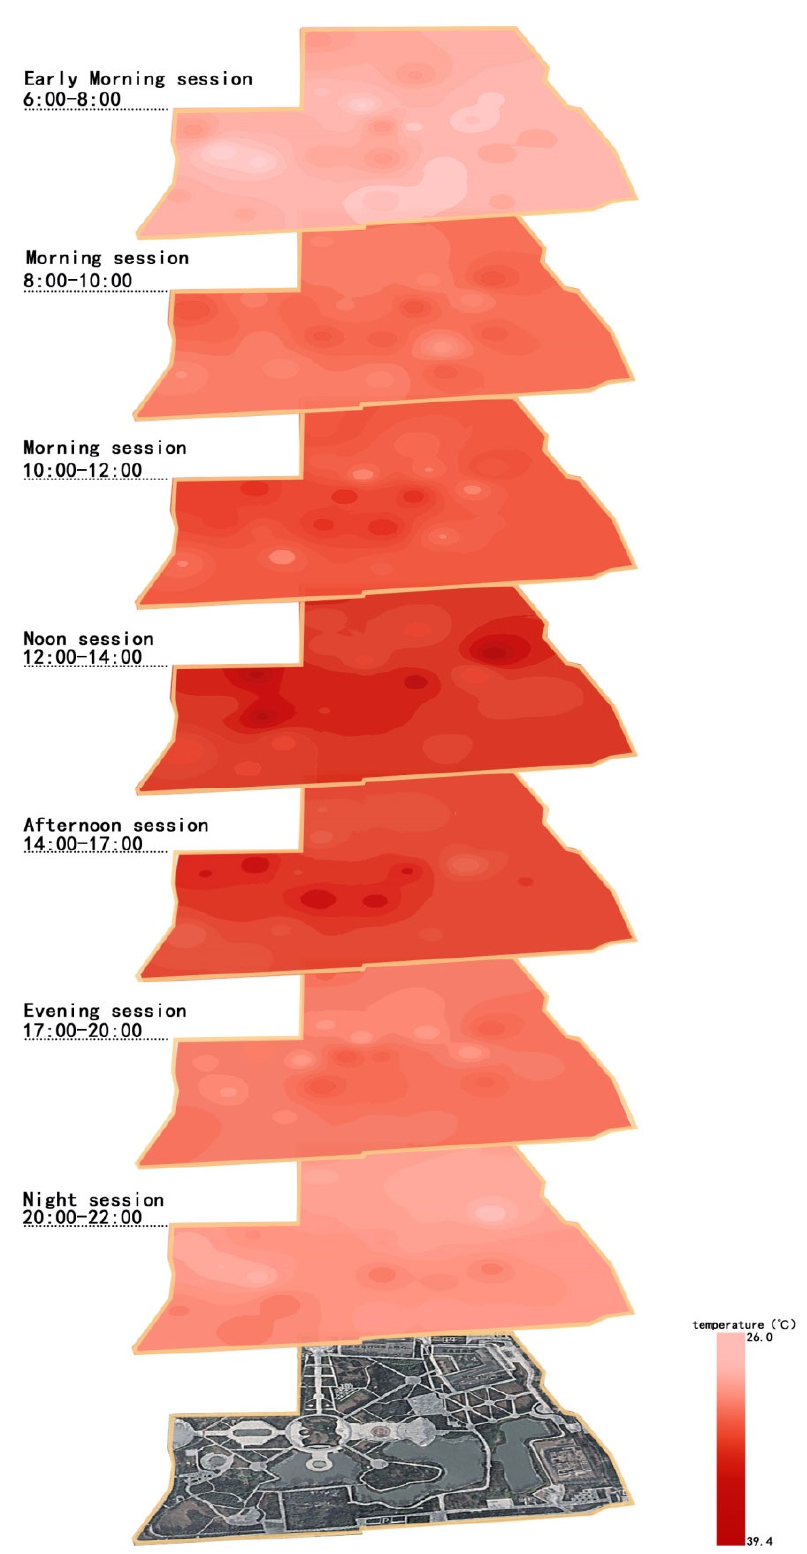
Figure 3. Temporal and spatial variation of park temperature.